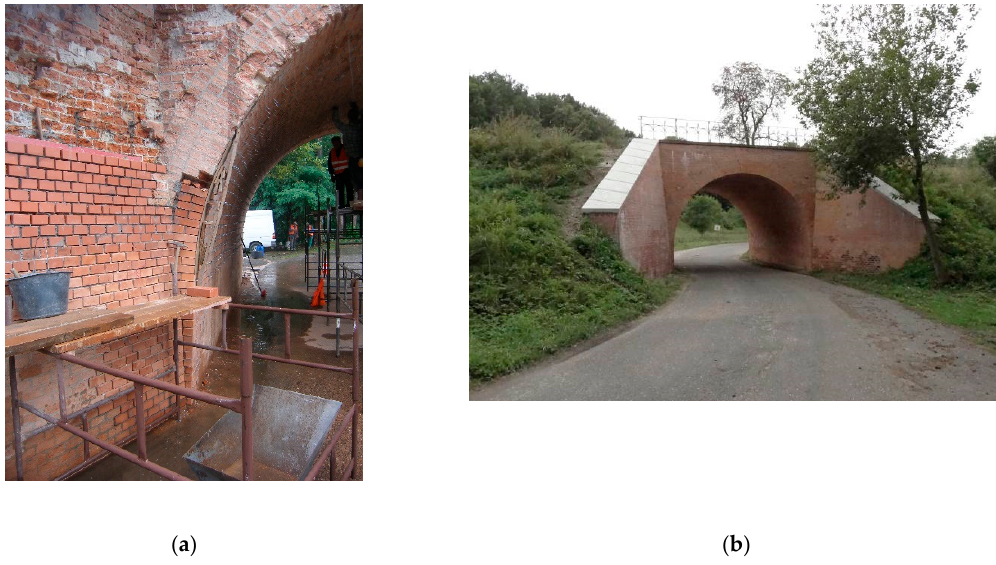
Figure 17. The injection system in the wall.